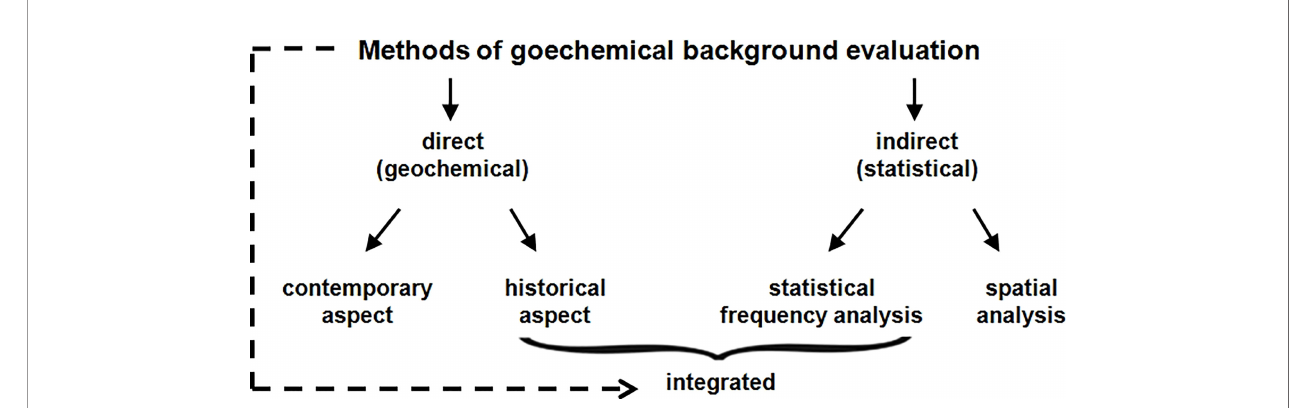
FIGURE 3 | The integrated method used to determine BGVs by the Italian National Network System for Environmental Protection (modi fi ed from Galuszka and Migaszewski,